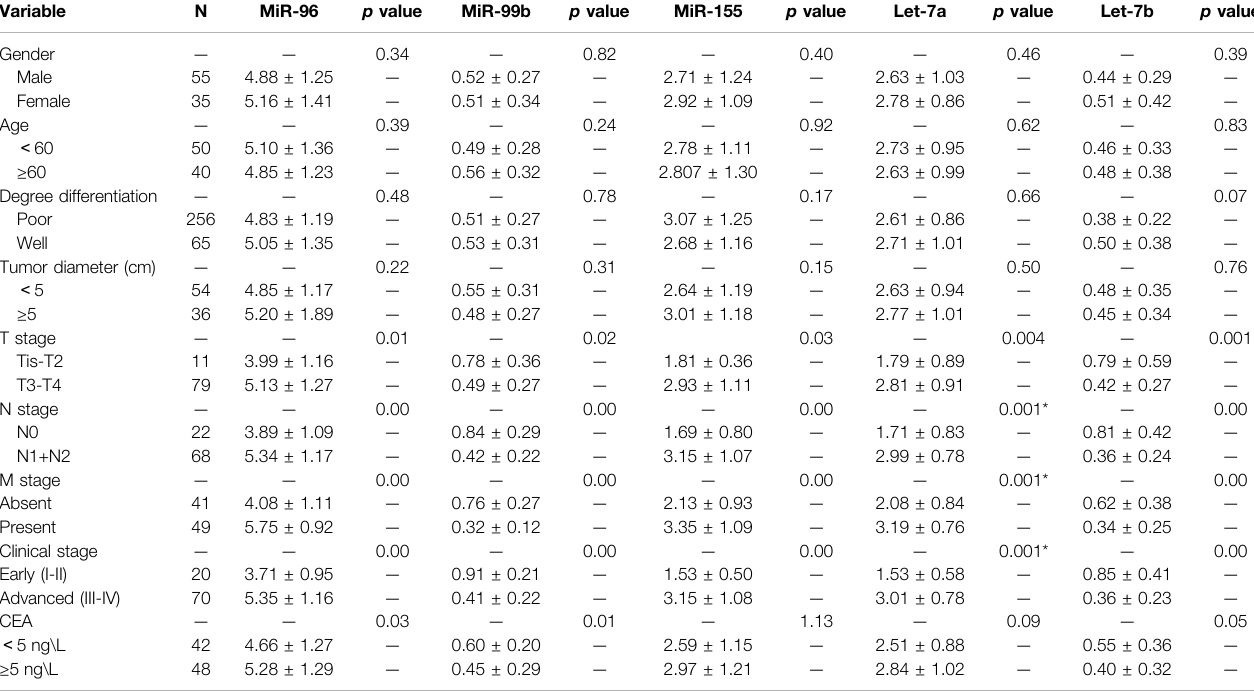
TABLE 3 | Association of miRNAs expression levels with clinico-pathological factors of colorectal cancer patients (presented as mean ± SD).